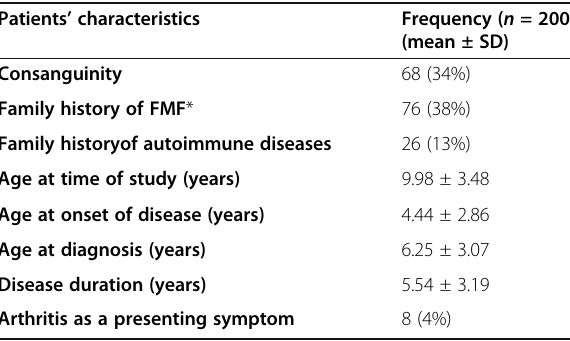
Table 1 Demographic features of studied FMF patients according to age, family history, consanguinity , disease duration and arthritis